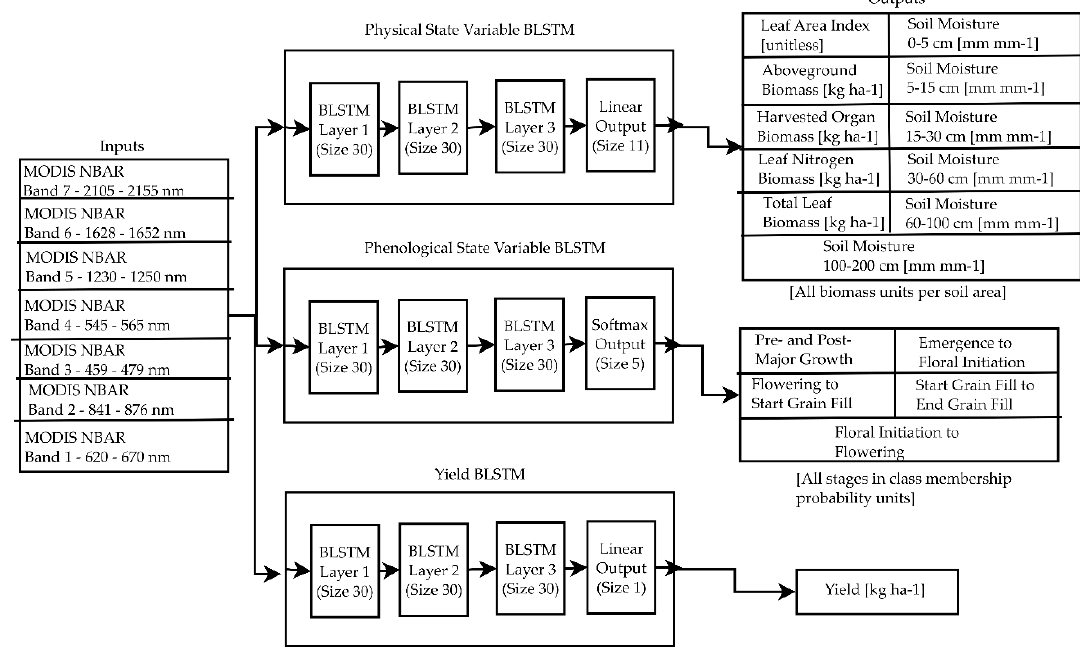
Figure 3. Architecture of BLSTMs used in study. Three separate BLSTMs are used to predict the physical state variables, phenological state variables, and yield from the satellite measurements. The layers of the BLSTMs, according to the definitions used in CURRENNT, are shown for each BLSTM. Different BLSTMs are used for the different types of variables for the following